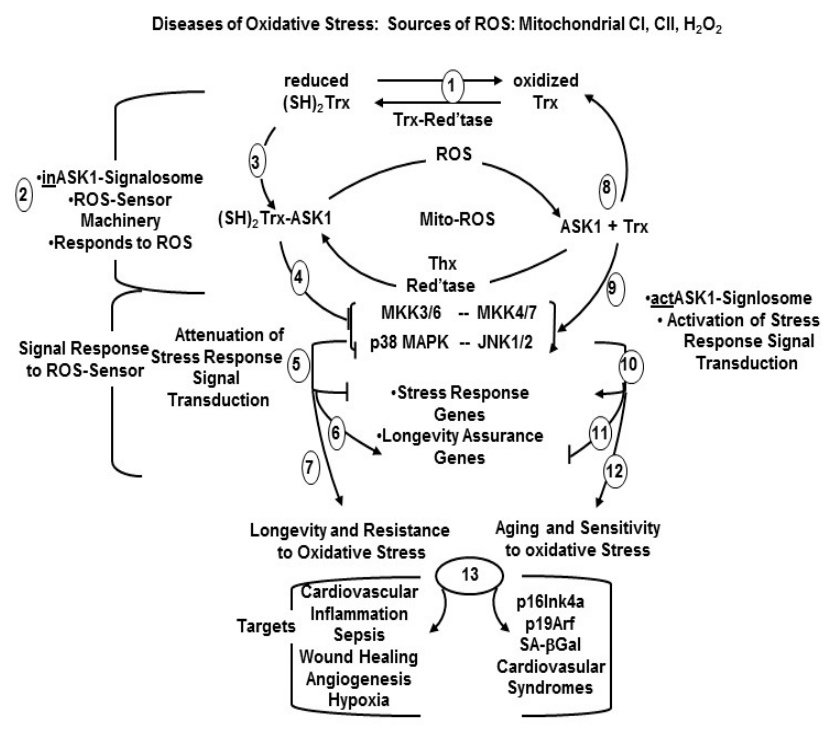
Figure 6. The pathways that promote longevity and resistance to oxidative stress vs. aging and sensitivity to oxidative stress. (1) Thioredoxin reductase plays a major role in balancing the overall cellular oxidation-reduction homeostasis; (3) Reduced Thx binds to the amino terminal of ASK1 to form the inhibited ASK1-signalosome; (4) the inASK1-signalosome attenuates the stress response pathway; (5,6) the stress response genes are attenuated; (7) the longevity response genes re activated; (8) Oxidized Thx is reduced by Thx reductase; (9) The actASK1-signalosome activates the stress response signaling pathway which; (10, 11, 12) activates stress response genes and attenuates longevity assurance genes; (13) the targets of the attenuated stress response pathway favor longevity and resistance to oxidative stress; (13) the act Signalosome promotes aging and sensitivity to oxidative stress and cardiovascular syndromes.